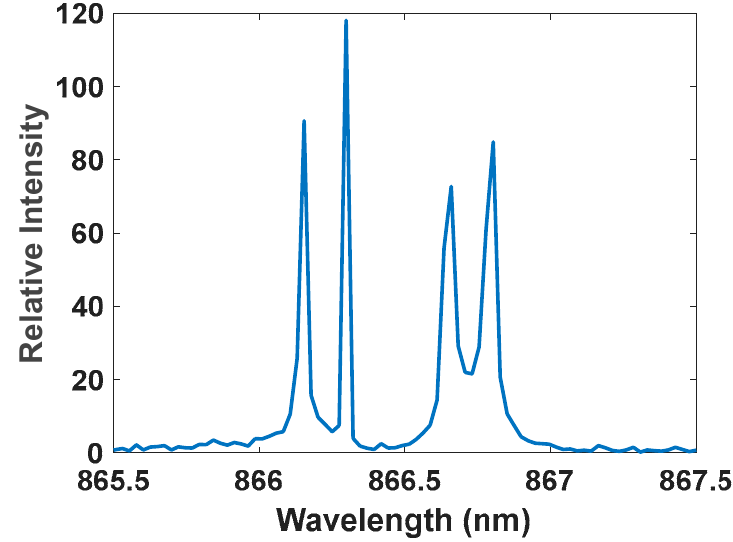
Figure 12. The recovered spectrum.